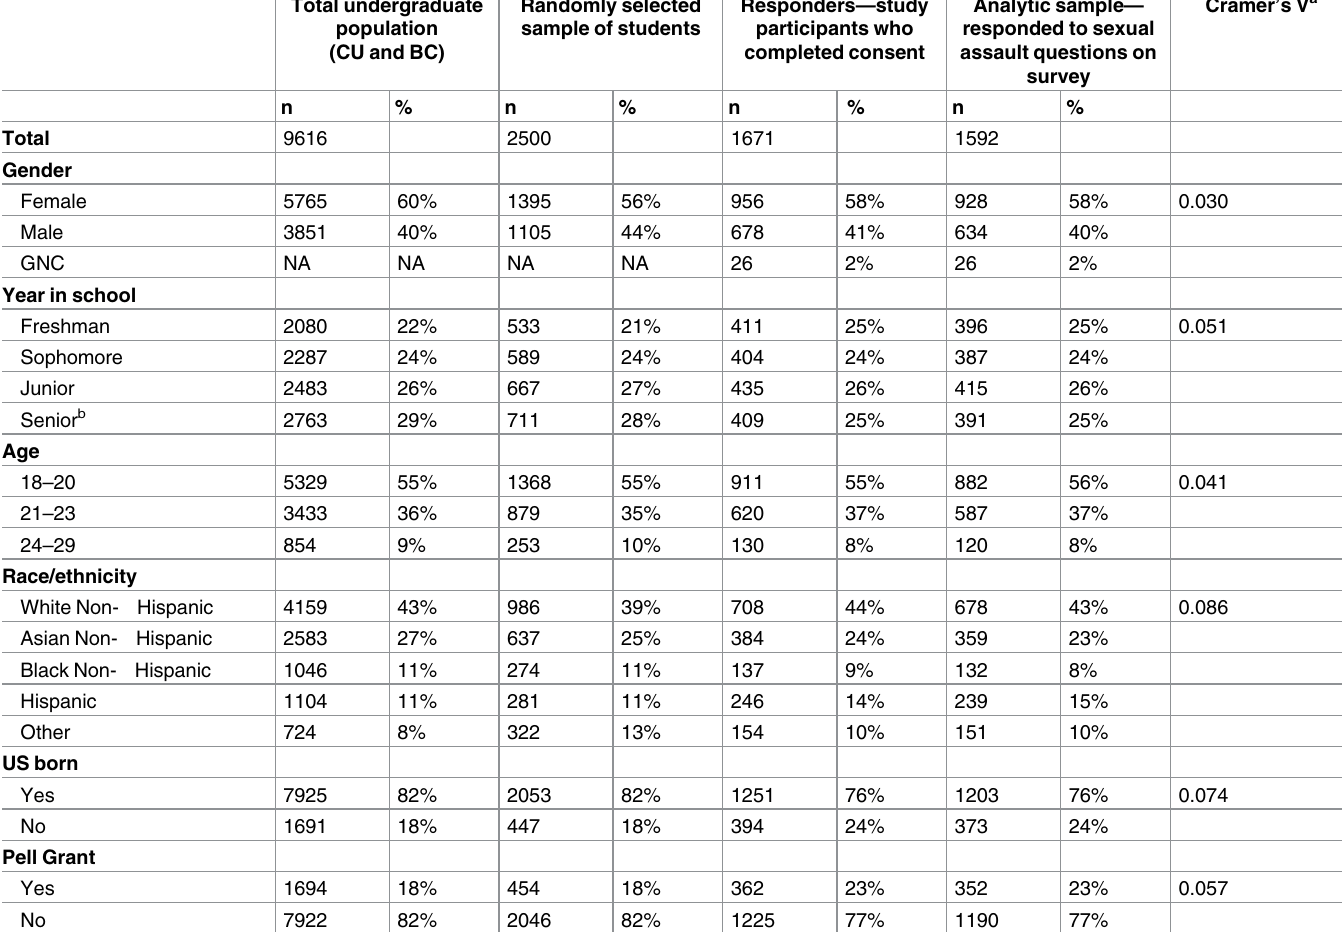
Table 1. Demographics of random sample and responders of undergraduates at